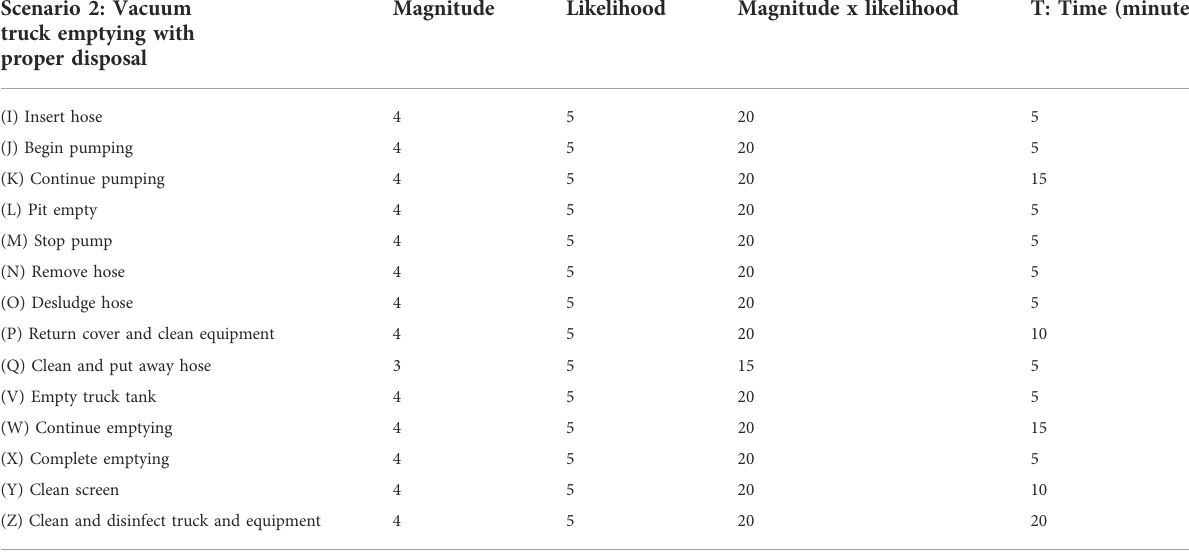
TABLE4Scenario2,Excerptoffecalaerosolinhalationriskscoresforvacuumtruckemptyingwithproperdisposal.Operatordoesnotenterthetruck for cleaning. Solid lines between rows denotes to a break in steps. See Supplementary Material for the complete set. Scenario 2: Vacuum truck emptying with proper disposal